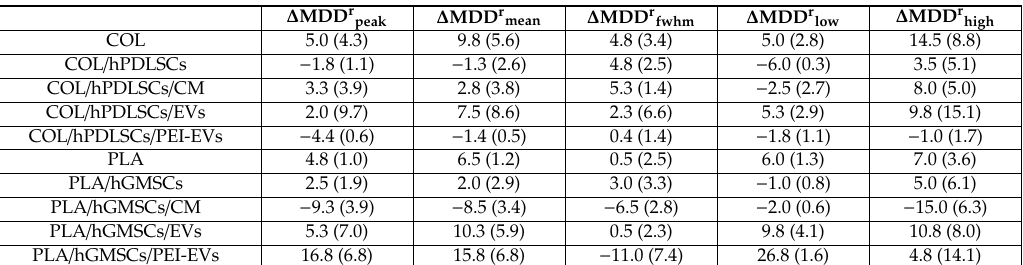
Table 1. Bone relative mass density distribution (MDD r )—results. Instead of the absolute indices, the following relative parameters were studied in each rat included in the groups of study: ∆ MDD r i = MDD r i,ctr − MDD r i,test , where i defines each index between peak, mean, fwhm, low and high. Data are shown as mean (standard deviation) for each group of study. ∆ MDD r ∆ MDD r ∆ MDD r mean peak